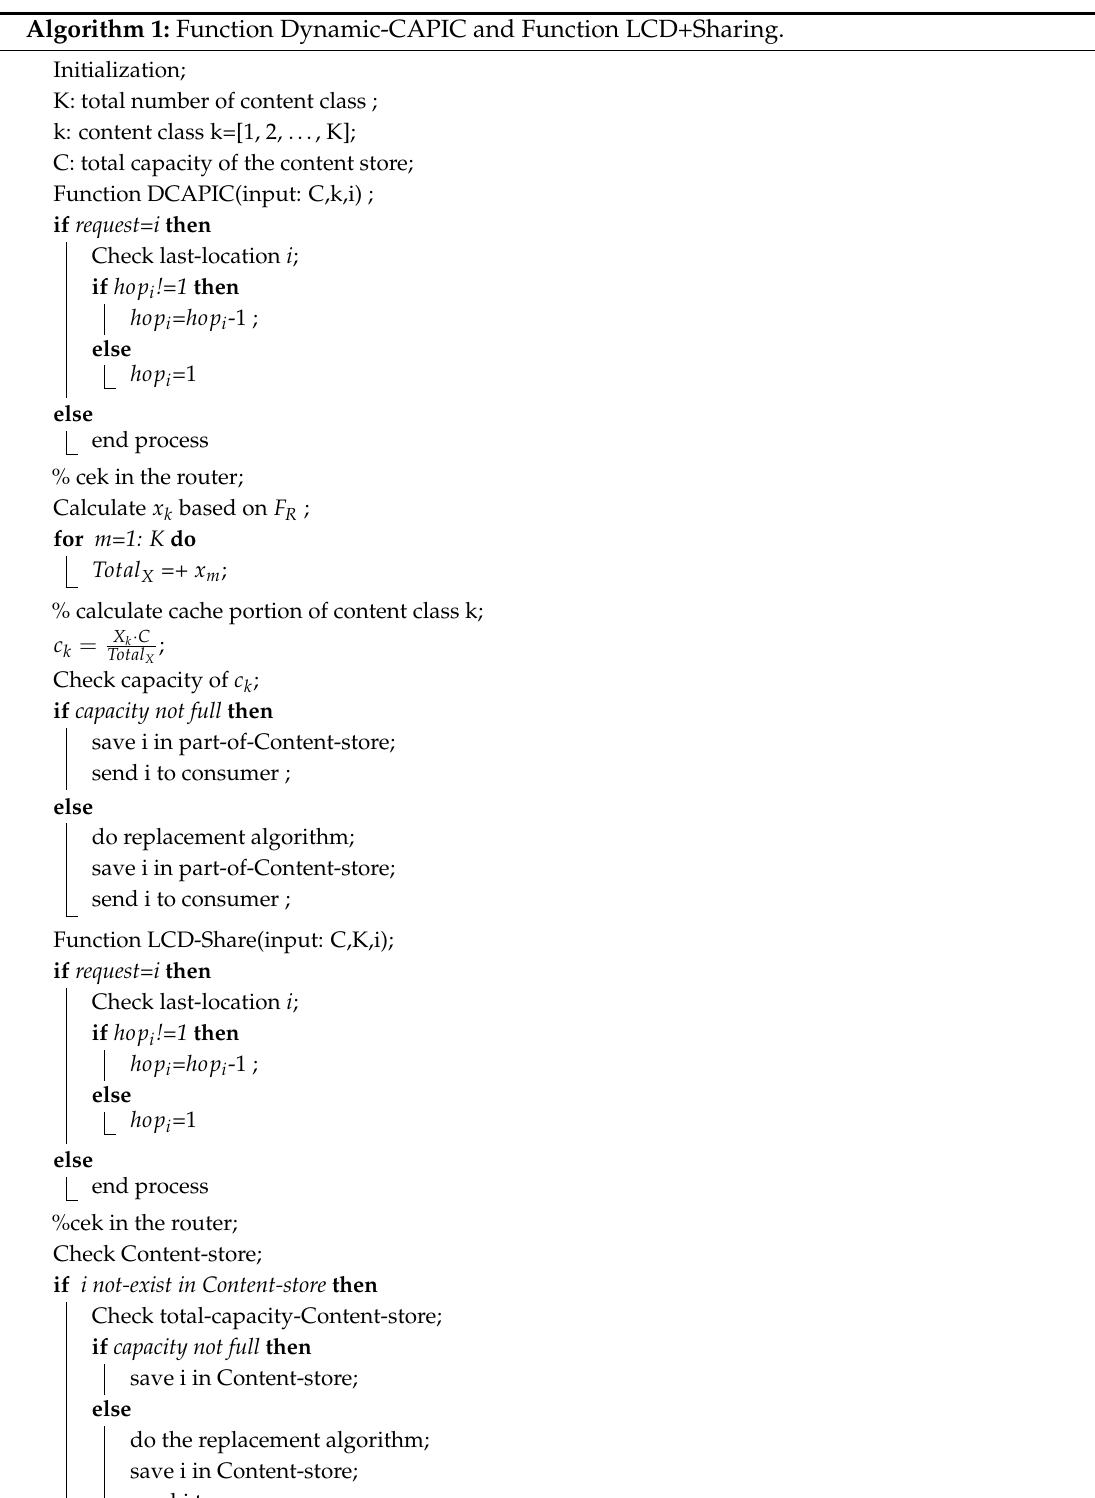
Algorithm 1: Function Dynamic-CAPIC and Function